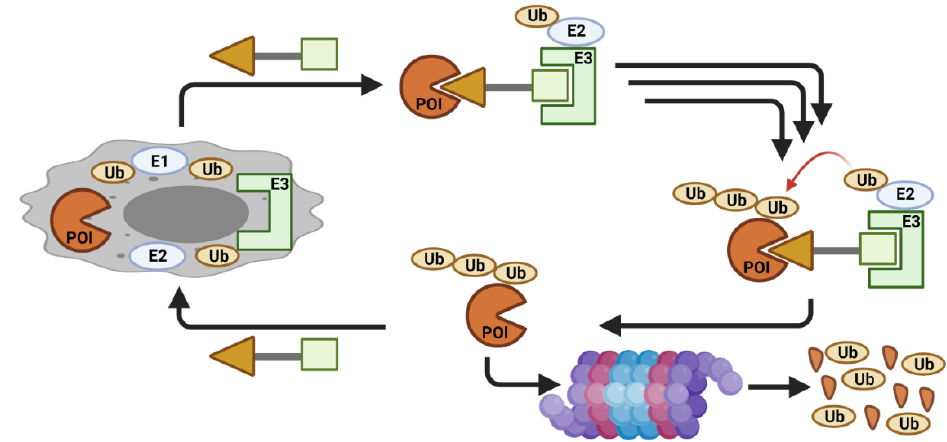
Figure 2. Schematic cartoon showing a PROTAC mechanism of action (created with BioRender.com).